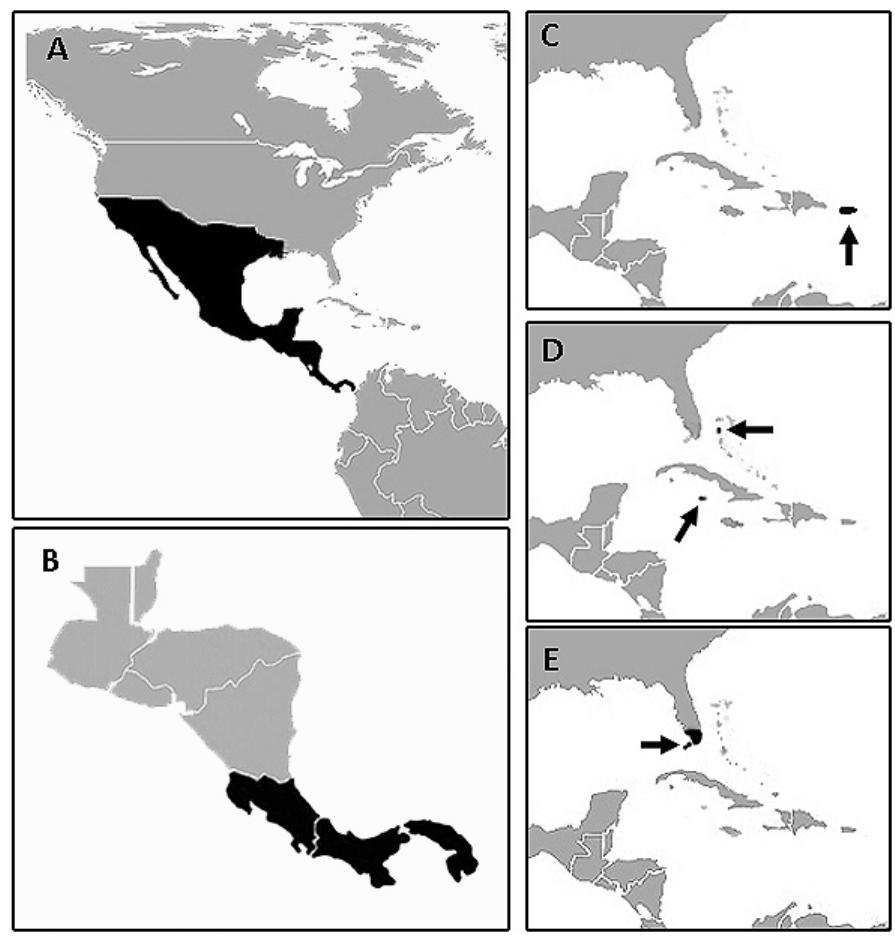
Figure 8. Distribution map of: A Neocallotillus elegans B N. intricatus C N. crusoe D Callotillus baha- mensis E C.